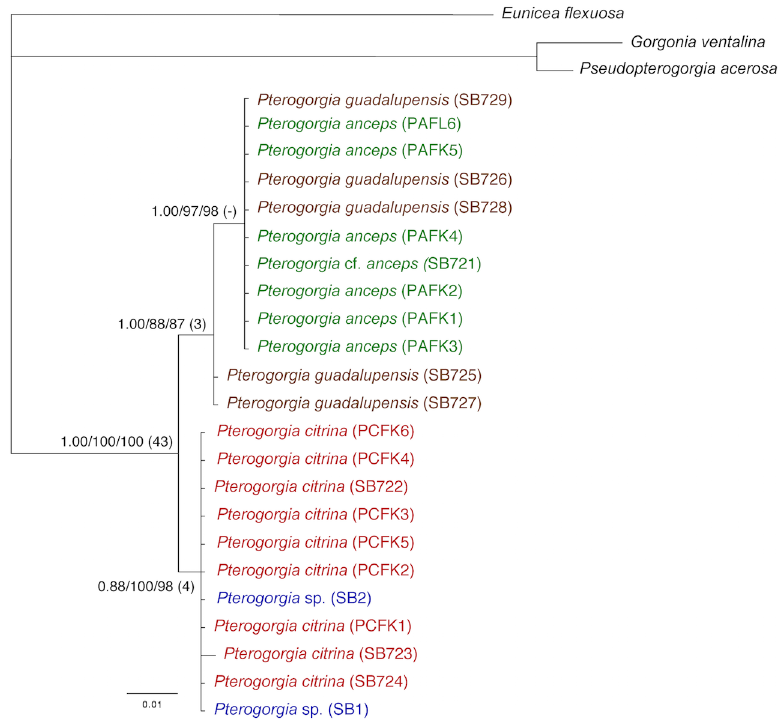
Fig 6. Concatenated dataset. Phylogram generated by a concatenated dataset including three mitochondrial fragments ( mtMutS + cytb + igr 4) and one nuclear ( SRP54 ) locus using Bayesian Inference (BI), maximum likelihood (ML), and maximum parsimony (MP). Node support for BI, ML and MP is shown from left to right, with Bremer decay values in parentheses.